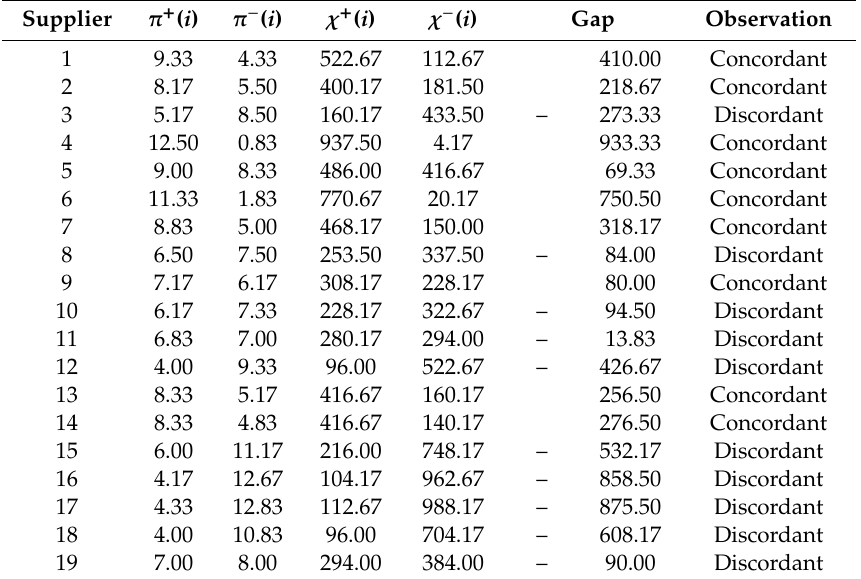
Table 3. Final concordant and discordant pair matrix and prioritization